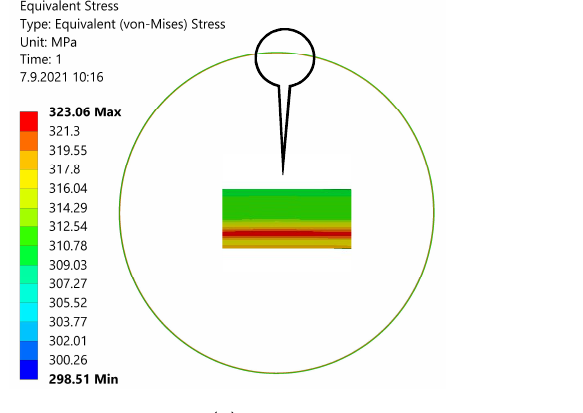
Figure 6. Mechanical analysis of the sleeve glued to the rotor: ( a ) Von Mises stress; ( b ) total deformation.